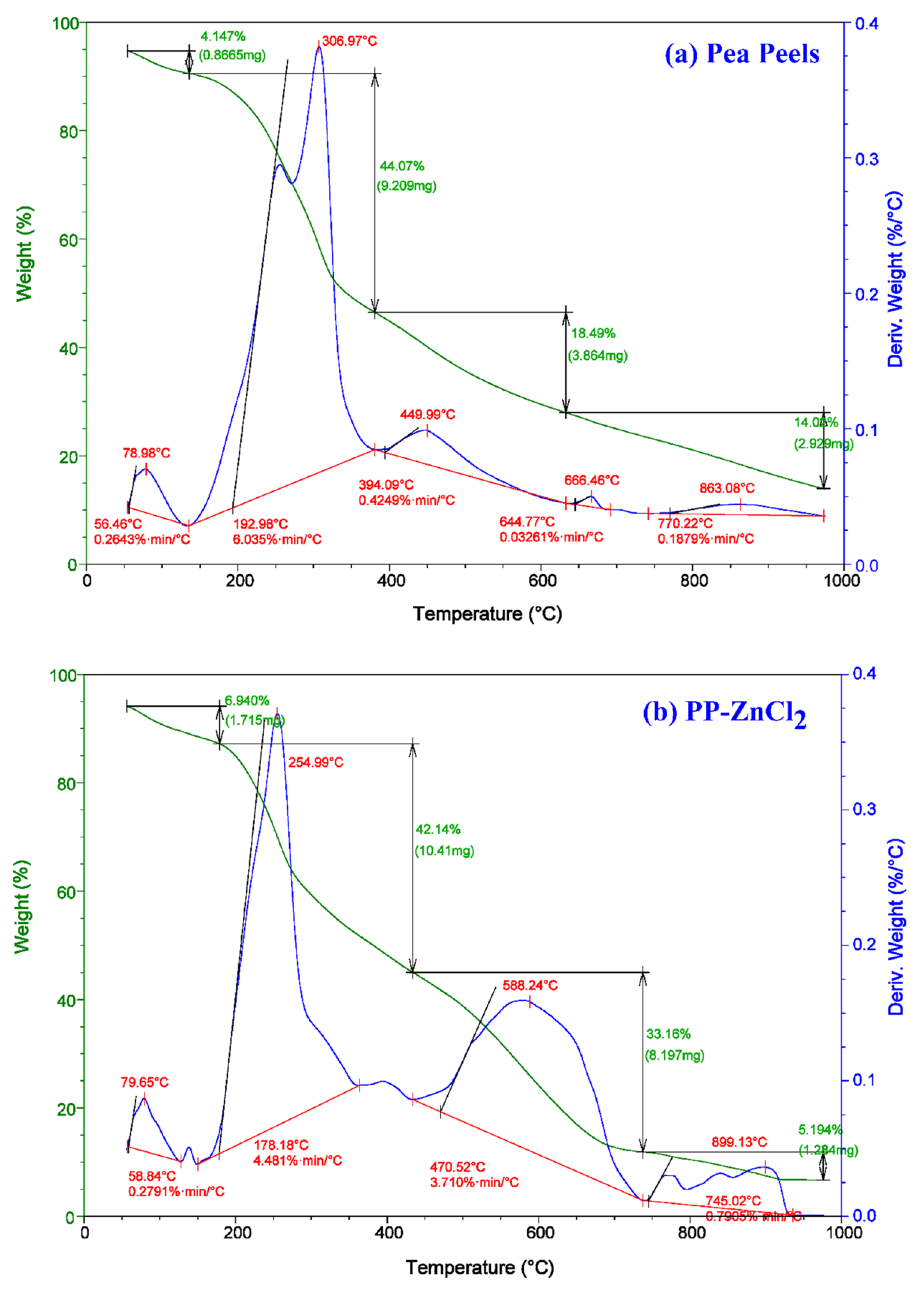
Figure 4. TGA and DTA of ( a ) Pea peels, and ( b ) PP-ZnCl 2 at temp. from 50 to 1000